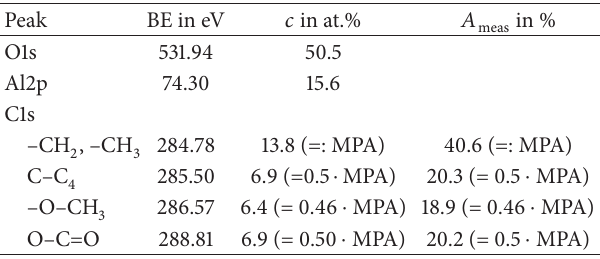
Table 4: Binding energies (BE) of relevant peaks, particular concen- tration 𝑐 𝑥 , and measured relative area 𝐴 meas of carbon bonds within the C1s peak of thick powder